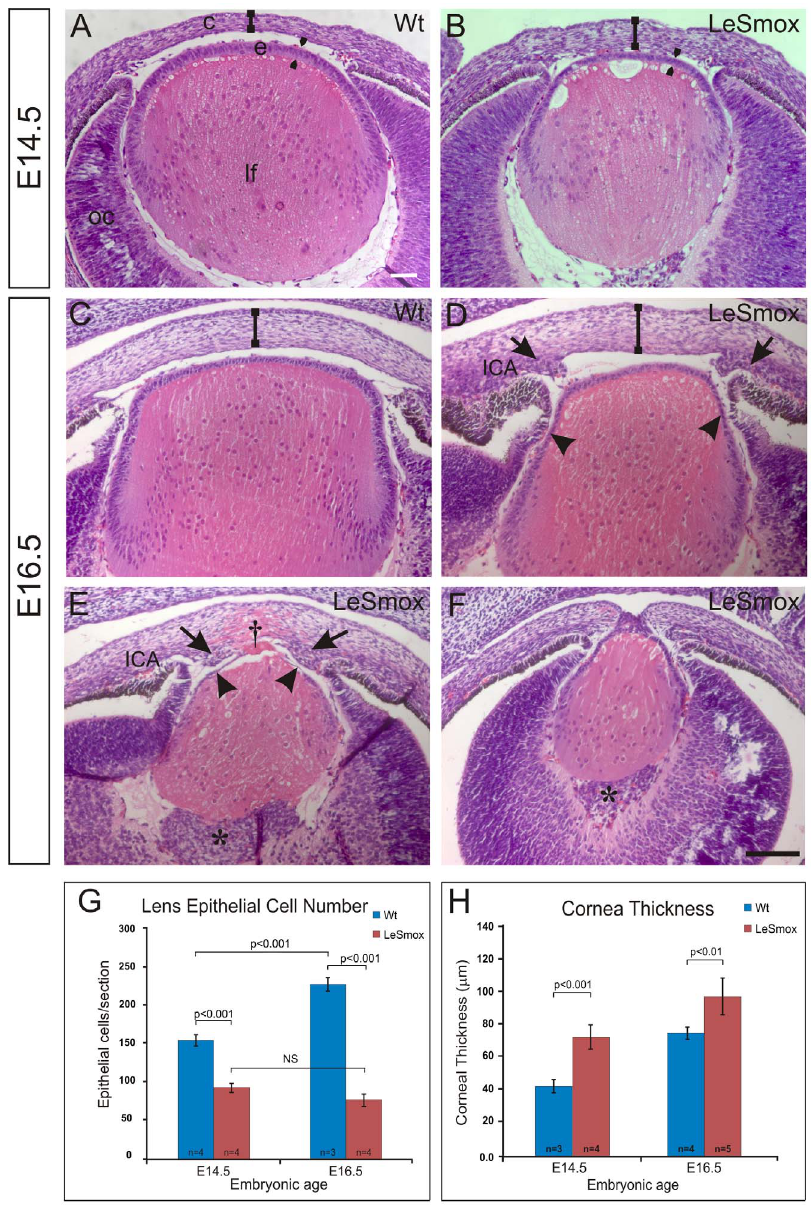
Figure 4. Embryonic ocular phenotype of LeSmox mutant mice. Histology of wild-type ( A, C ) and LeSmox ( B, D, E, F ) eyes at E14.5 ( A, B ) and E16.5 ( C–F ), showing reduction of epithelial thickness and size of lens at E14.5 and almost complete loss of the lens epithelium (arrowheads) by E16.5 (D,E). The thickness of the cornea is indicated by ‘I’. In some cases ( E ) the anterior lens ruptured, resulting in extrusion of lens cells into the cornea ( { ), whereas on other rare occasions there was a Peter’s anomaly ( F ). In almost all LeSmox eyes at E16.5 ( E, F ), aberrant cells (*) were seen to accumulate near the posterior pole of the lens, in the vitreal chamber, and also in the mesenchyme (arrows) near the irido-corneal angle (ICA) G,H. Quantification of lens epithelial cell number ( G ) and thickness of the cornea ( H ) in LeSmox eyes compared to Wt. Abbreviations: c, cornea; e, epithelium; OC, optic cup; ICA, iridial-corneal angle. Scale bar, A–F , 100 m m. not markedly different from that seen in the wild-type; distinctly labelled nuclei were present in the transitional zone below the lens equator (Fig. 5B, D, F, H) at both ages.